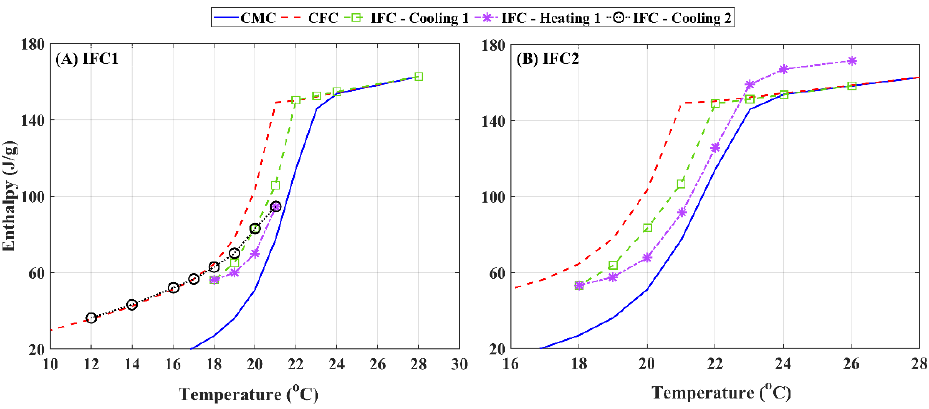
Figure 6. Temperature–enthalpy curves of ( A ) IMC1 and ( B ) IMC2 tests superimposed on CMC and CFC curves.